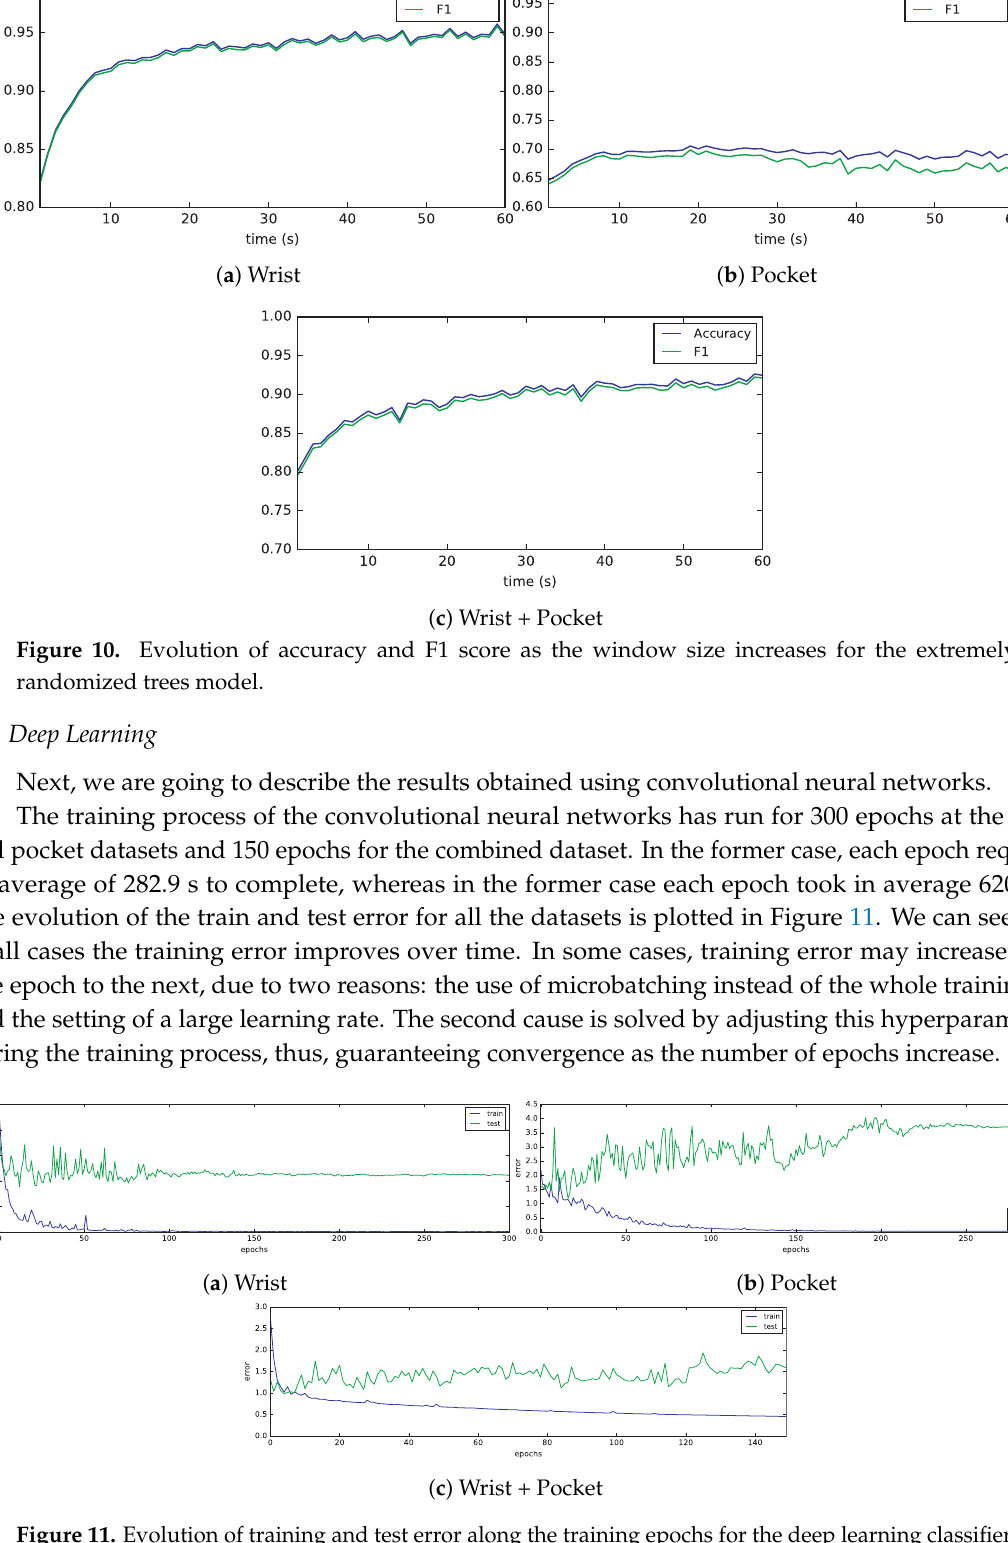
Figure 11. Evolution of training and test error along the training epochs for the deep learning